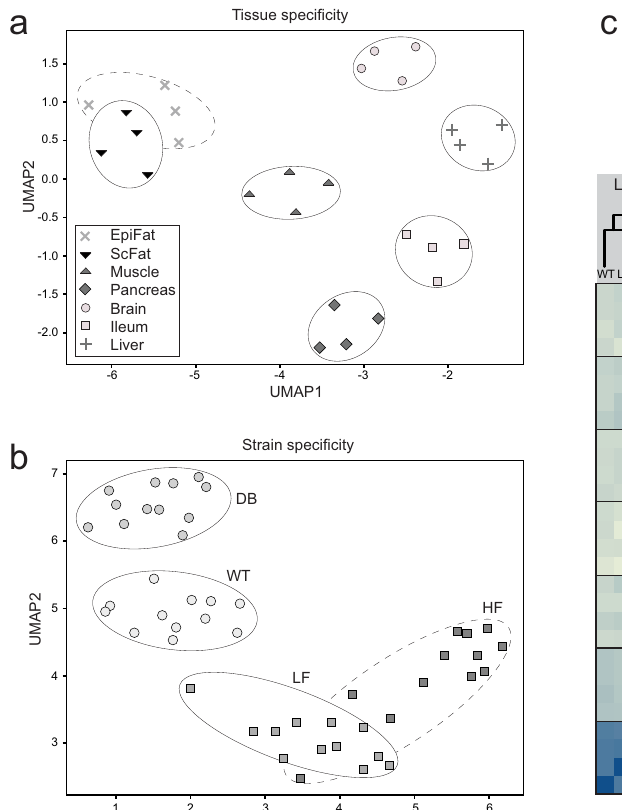
high-fat diet (HF). b Strain speci fi city using UMAP with only valid values. Each datapoint is one animal. c Pearson correlation plot based on all pairwise peptide intensities(abundance)withingroups.Medianintensityvaluesareusedwithineach n =12 group from the MaxQuant